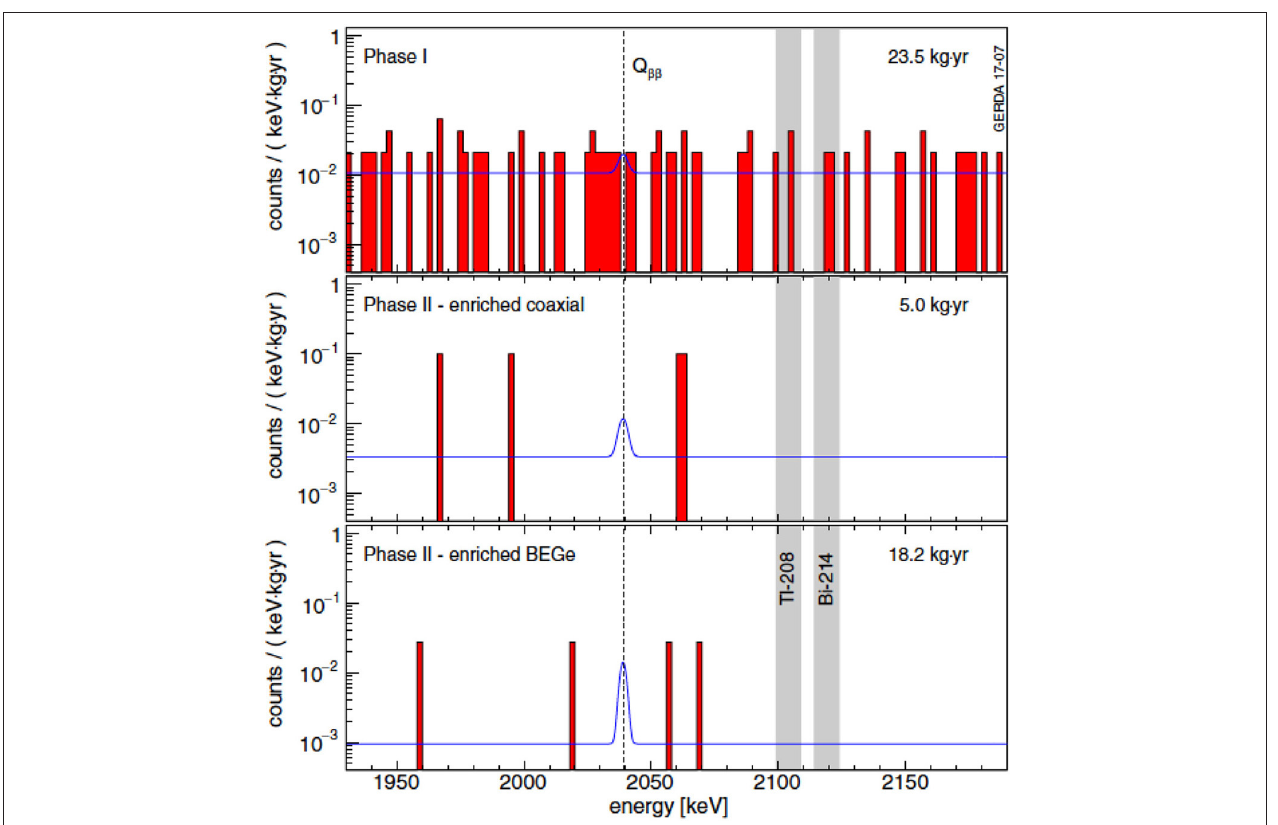
FIGURE 8 | The spectra from the various phases of GERDA near the Q ββ for Ge at 2,039 keV [47]. Figures courtesy of the GERDA Collaboration.